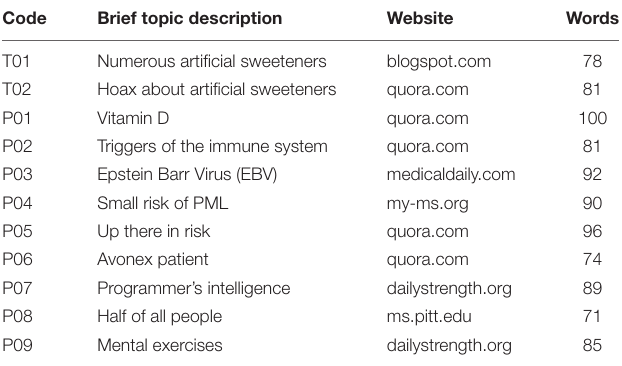
TABLE 1 | Original sources for text stimuli.